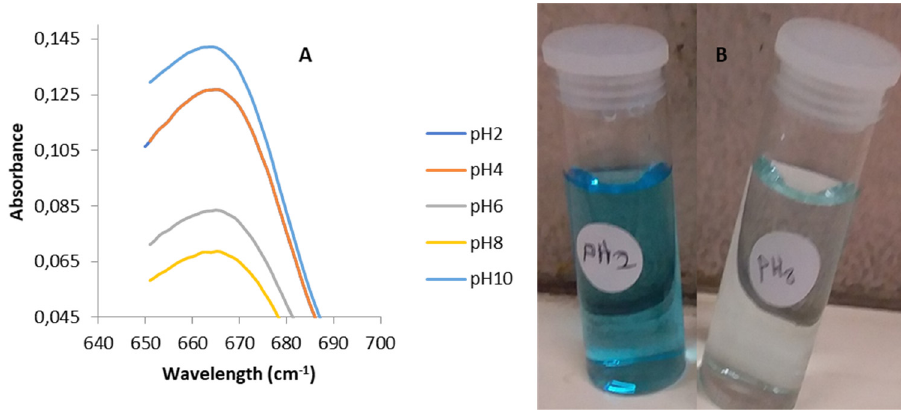
Figure 9. ( A ) UV-VIS spectra of methylene blue (MB) after adsorption at different pH; ( B ) pictures of MB solution treated with 0.015 g of FMWCNT/HKUST-1 at pH 2 and pH 8.